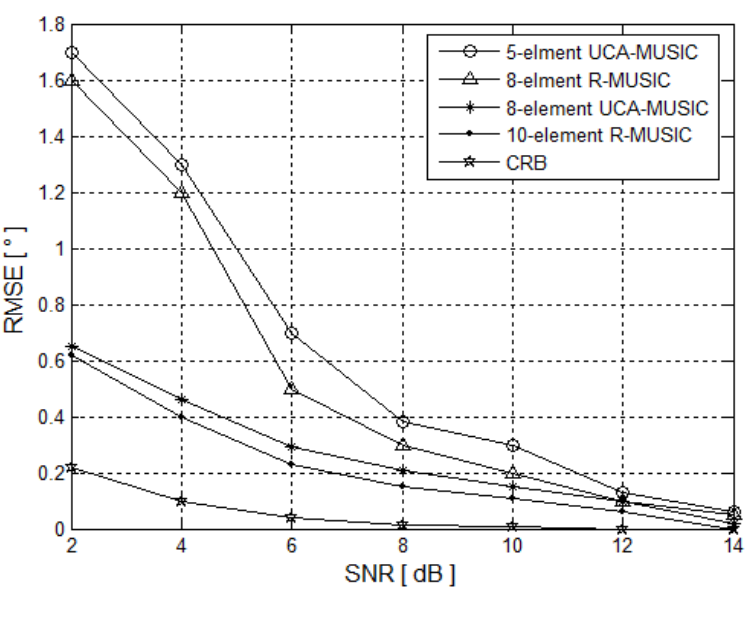
Figure 6. RMSE versus SNR.